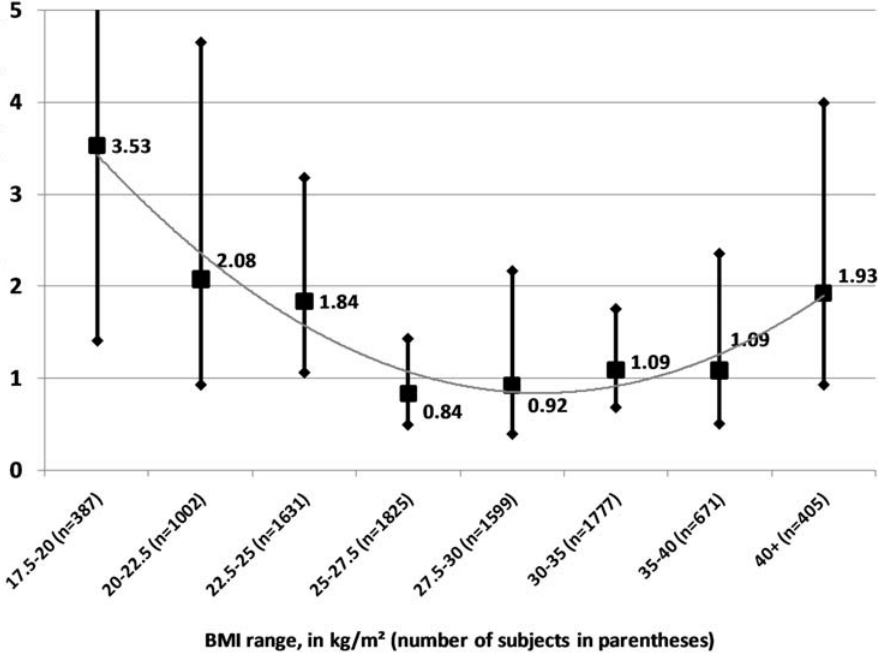
Figure 2. Adjusted Odds Ratios (aORs) comparing albuminuria among consumers of 2 + vs. 0–1 sugary soft drinks per day, stratified by body mass index (BMI) category. Trend line shows a quadratic model fit to the aORs; vertical lines represent 95% Confidence Intervals. The aORs are adjusted for age, race, ethnicity, and poverty status, but not BMI. BMI is used only as a stratification variable. Figure excludes subjects with BMI , 17.5 kg/m 2 (n=61).